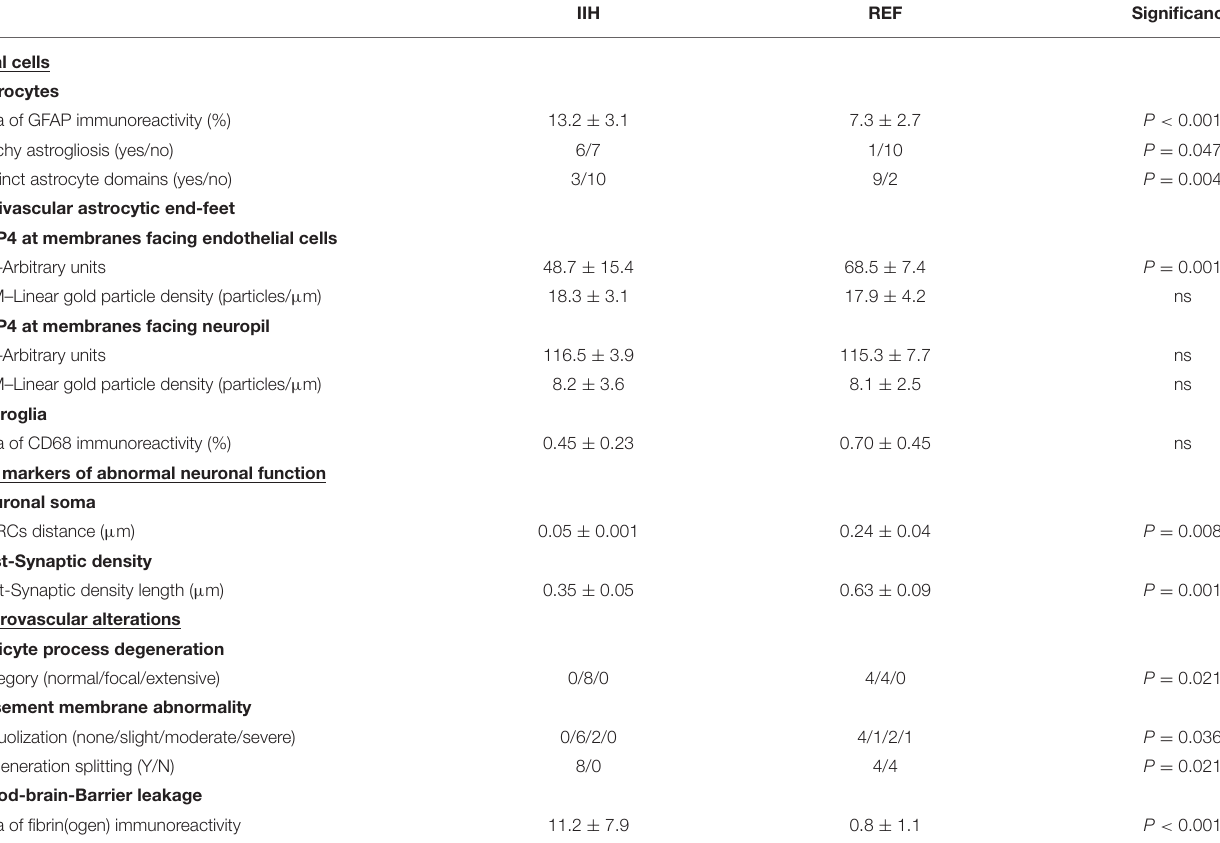
TABLE 3 | Comparisons of structural differences at glia-neuro-vascular interface of patients with definite IIH and reference (REF)